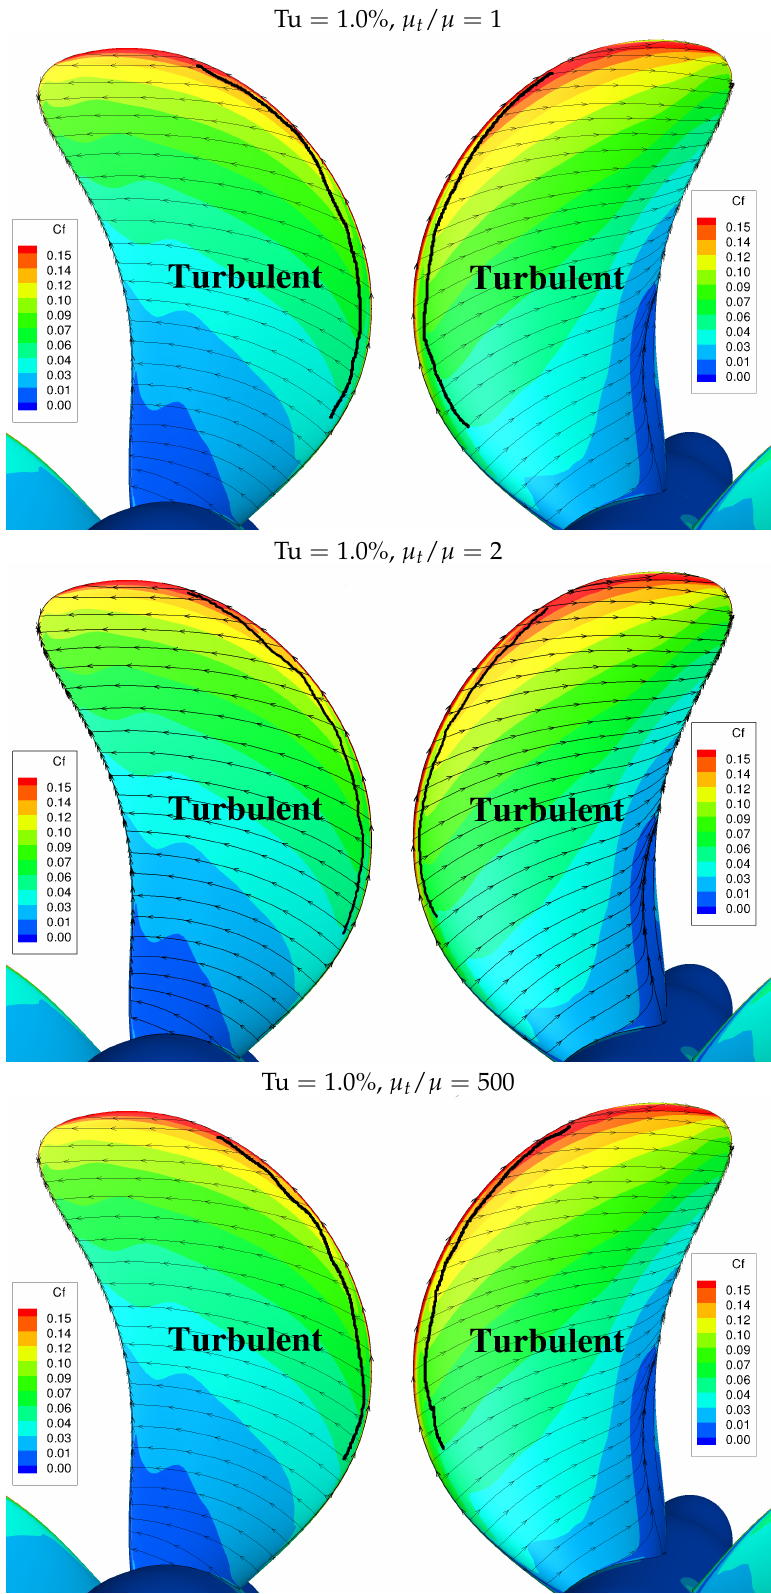
Figure 9. Influence of the inlet turbulence quantities on the propeller blade flow. Limiting streamlines and skin friction coefficient using the k − ω SST turbulence model at Re = 1 × 10 6 for J = 0.568. Pressure side ( left ) and suction side ( right